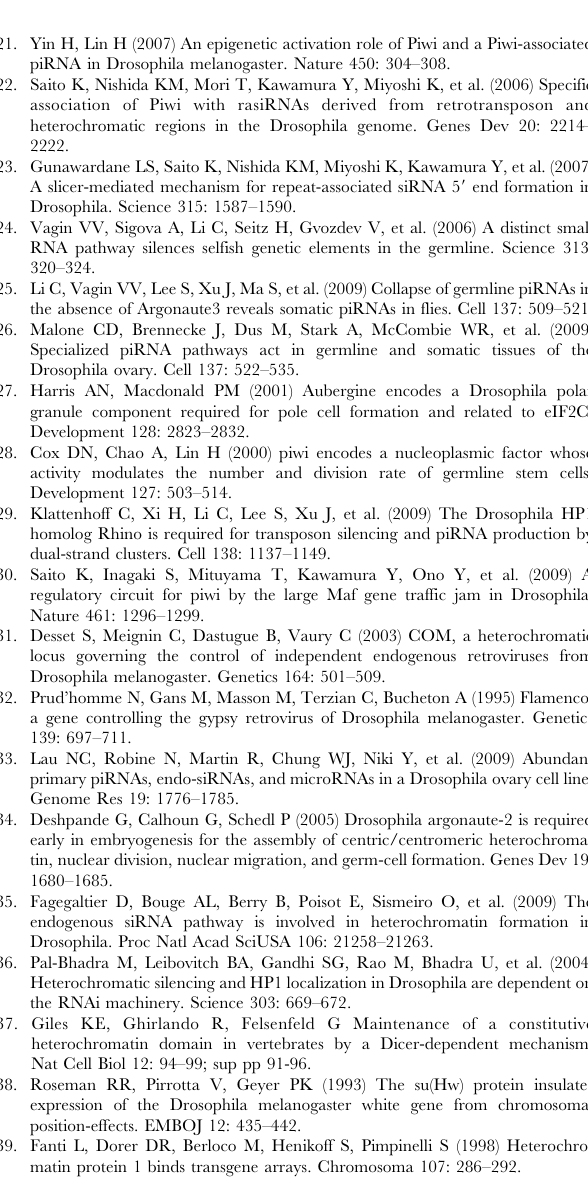
(B) 80EF piRNA loci are graphed as a function of C t values over DNA concentration. Cycle threshold (C t ) values of standard curves of input from a representative experiment were graphed to show that primers to piRNA clusters amplify in the same DNA dilution range as primers specific to single copy genes hsp26 and yellow compared to high copy TE elements. Table S1 Primer set sequences used for ChIP at the flam piRNA cluster.